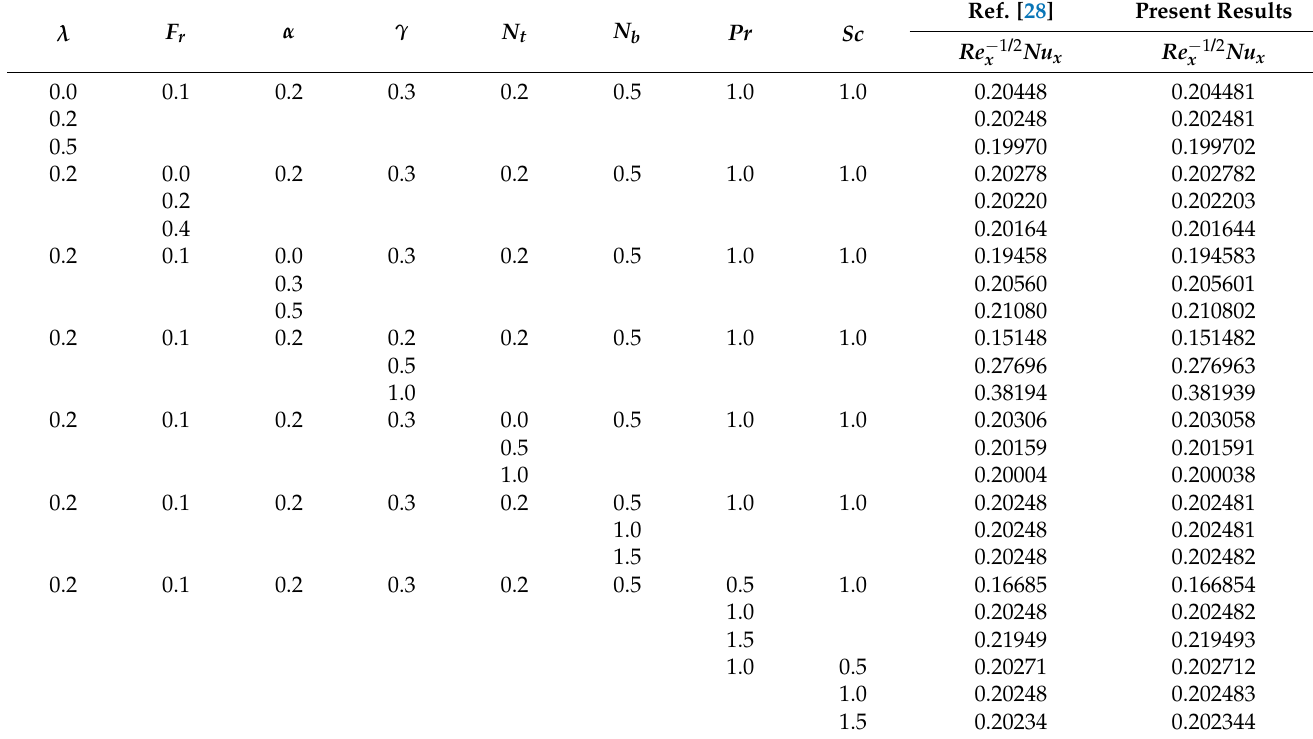
Table 2. Computational values of Nusselt number for diverse parameter